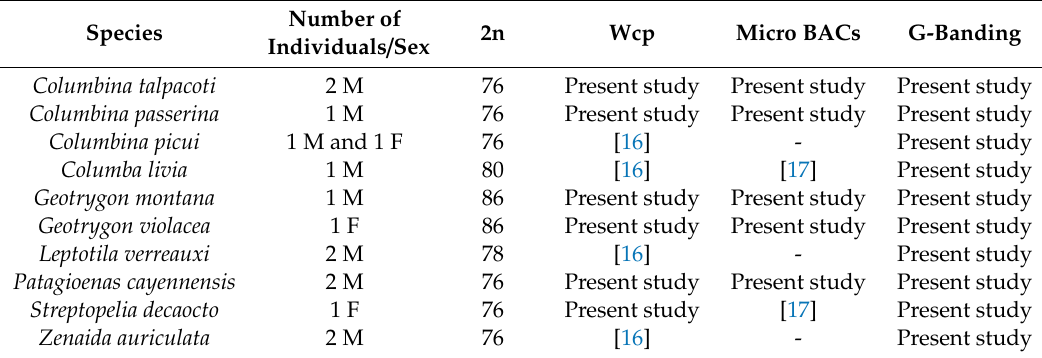
Table 1. List of Columbidae species and cytogenetics methods performed in this study. WCP = whole chromosome